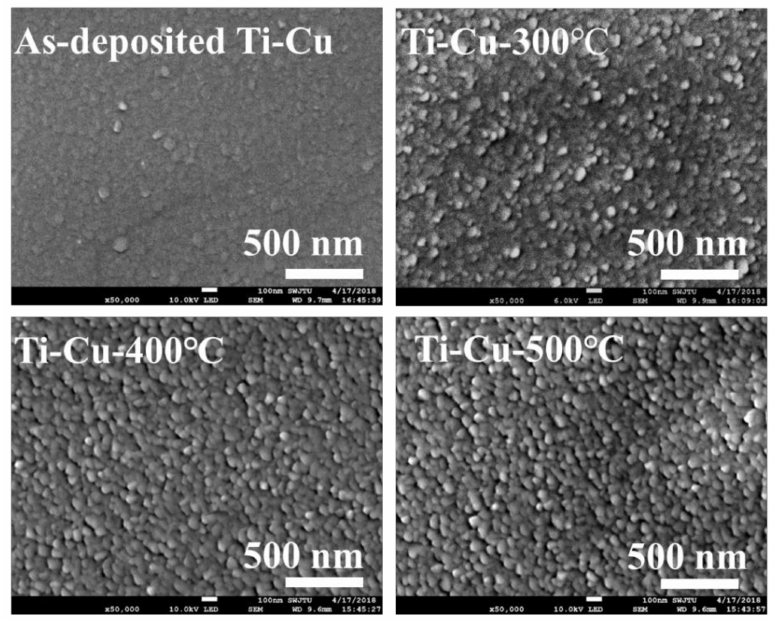
Figure 6. SEM micrographs showing the surface morphologies of Ti–Cu coatings before (as-deposited) and after annealing at varied temperature of 300, 400, and 500 ◦ C. The coatings were deposited on silicon substrates.